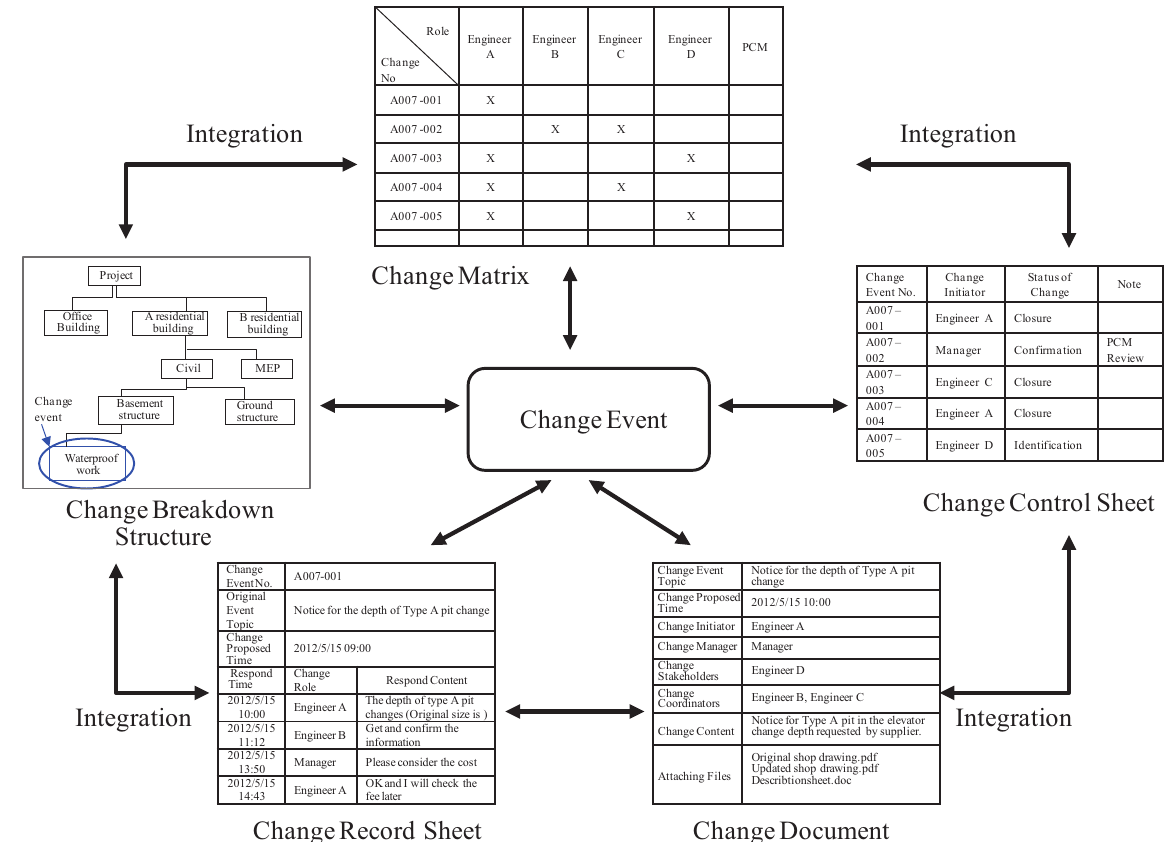
Fig. 2. Proposed system